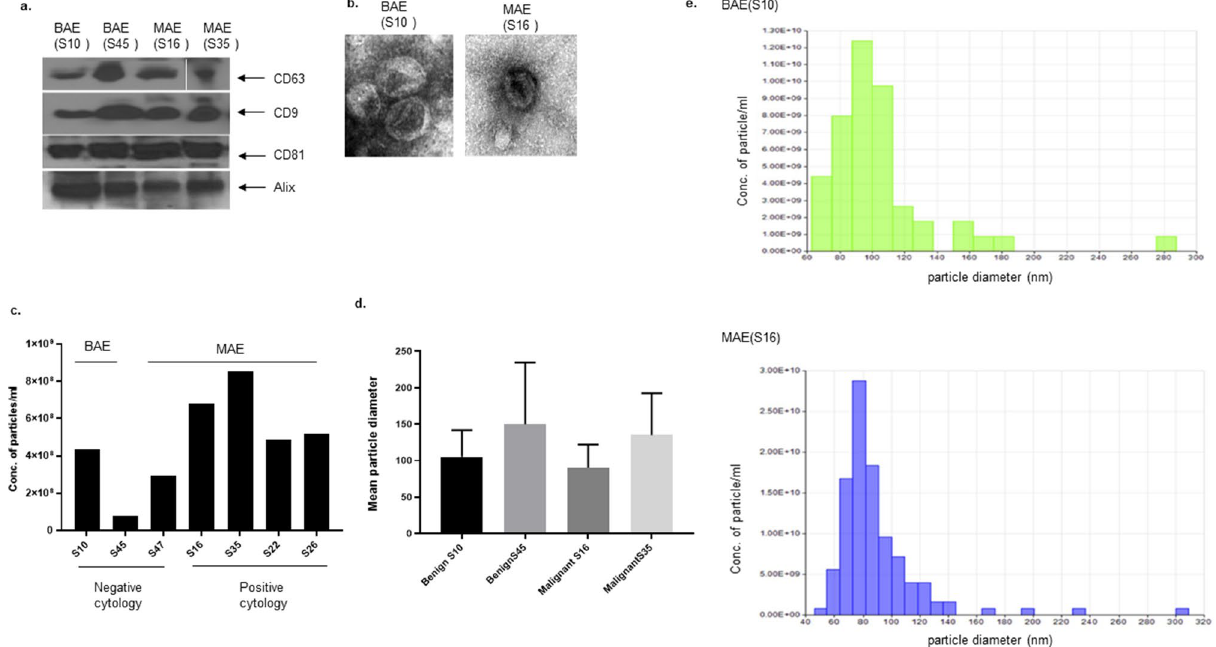
Figure 1. Characterization of exosomes. Expression of exosome specific markers (CD63, CD81, CD9, and Alix) in exosome derived proteins by western blot. Exosomes were either isolated from Benign tumor associated (BAE) or malignant tumor associated (MAE) ascitic supernatant ( a ). Representative TEM images of exosomes isolated from benign and malignant tumor associated ascitic supernatants ( b ). Mean exosomal particle diameter in benign and malignant tumor associated ascitic supernatants ( d ). The concentration of particles per ml of ascites derived supernatants measured by qNano ( c , e ).